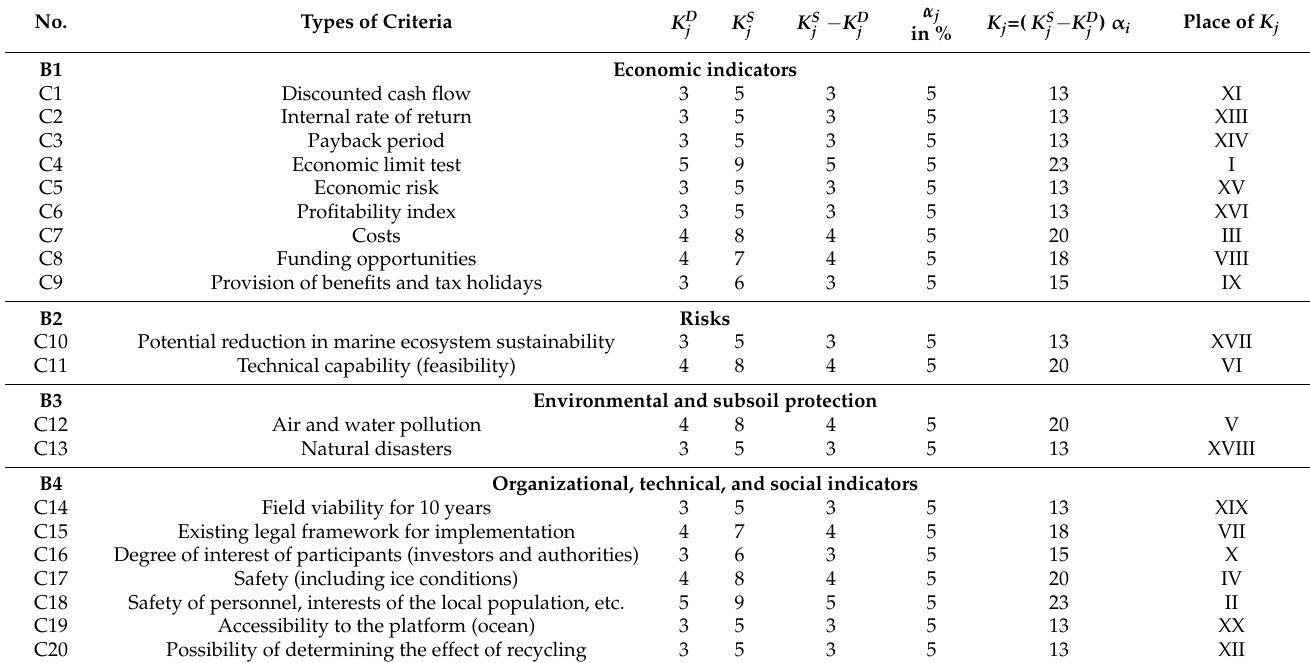
Table 4. Ranking and selection of criteria for assessing the decommissioning of offshore structures